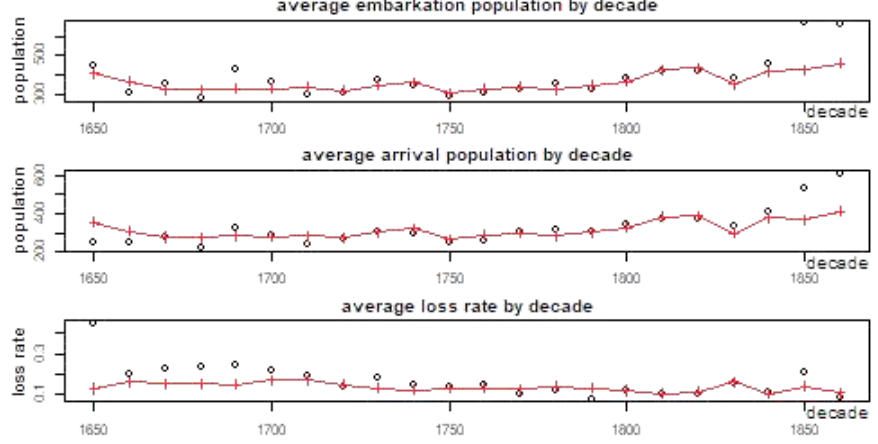
Figure 8. Captives: Documented embarkations, arrivals, and loss rates, averaged by decade (circles); and simulated data, assuming constant average flow per voyage (red lines). (Data3 “Documented routes & captives,” 4899